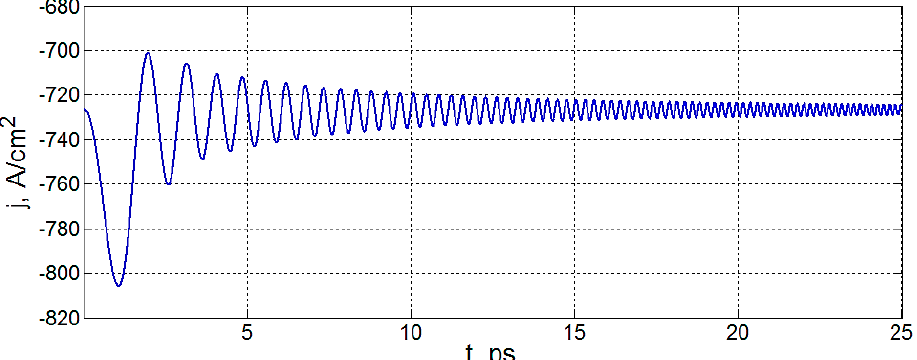
Figure 9. The dependence of photocurrent density on time computed for device being illuminated by the optical signal with sinusoidally-modulated volume density of optical power at the frequency ranging from 300 GHz to 3 THz. Figure 10. Amplitude-frequency characteristics of different types of GaAs photodetectors calculated at the frequency ranging from 300 GHz to 3 THz.